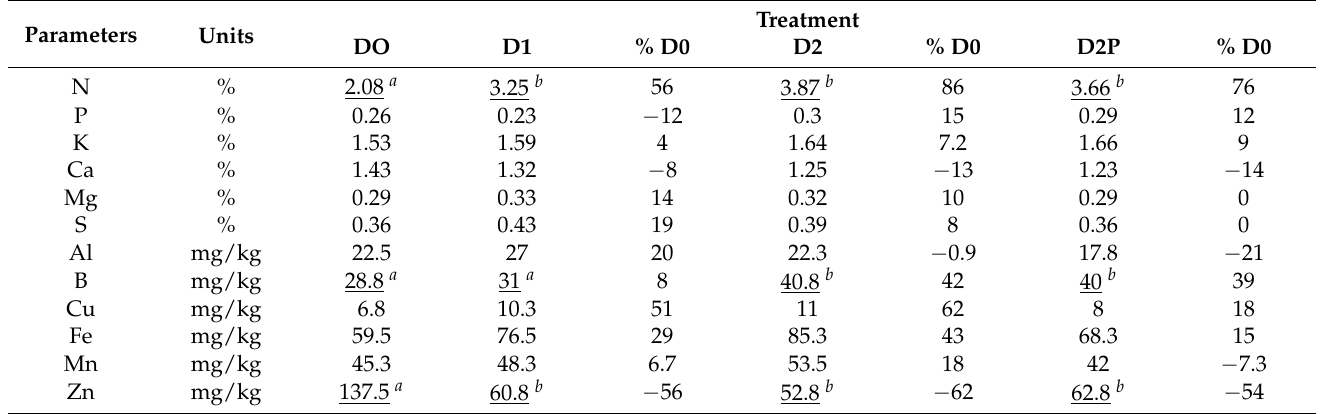
Table 4. Leaf micro- and macro-element concentrations in 2020 expressed as % of dry weight or in mg/kg dry weight with comparison to